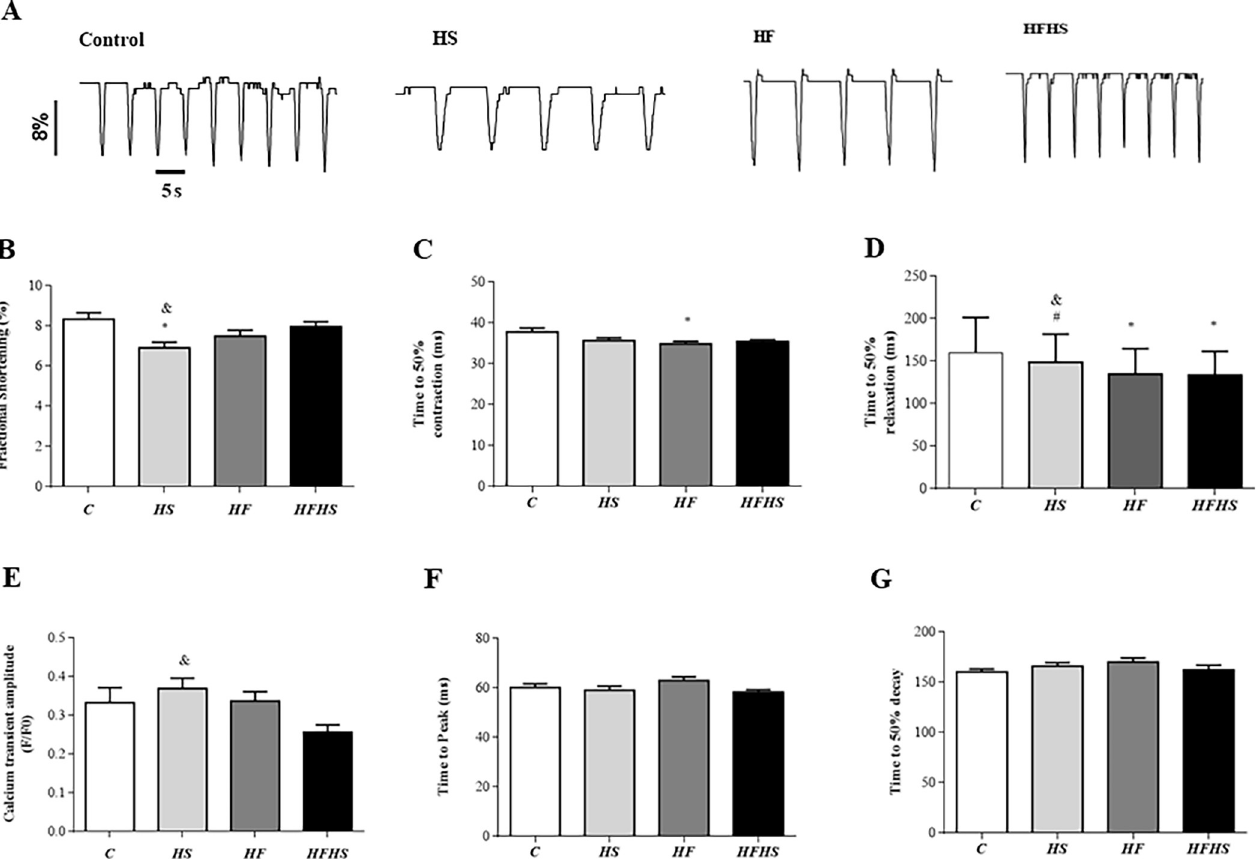
Fig 4. Effect of different diet composition on contractile function and calcium transients of left ventricular cardiomyocytes. Control diet (C; n = 5; cells = 71), high-sugar diet (HS; n = 6, cells = 115), high-fat diet (HF; n = 6, cells = 106) and high-fat and high-sugar diet (HFHS; n = 5, cells = 81). Data are shown as mean ± SEM. (A) Representative contraction traces obtained from the cardiomyocytes of rats: (B) Cell shortening expressed as % of resting cell length. (C) Time to 50% of contraction. (D) Time to 50% of relaxation. (E) Amplitude of transients. (F) Time to peak. (G) Time to from peak transient to half resting value p < 0.05 vs. � C; # HS vs. HF; & HFHS vs. HS. One-way analysis of variance (ANOVA) followed by the Tukey post hoc